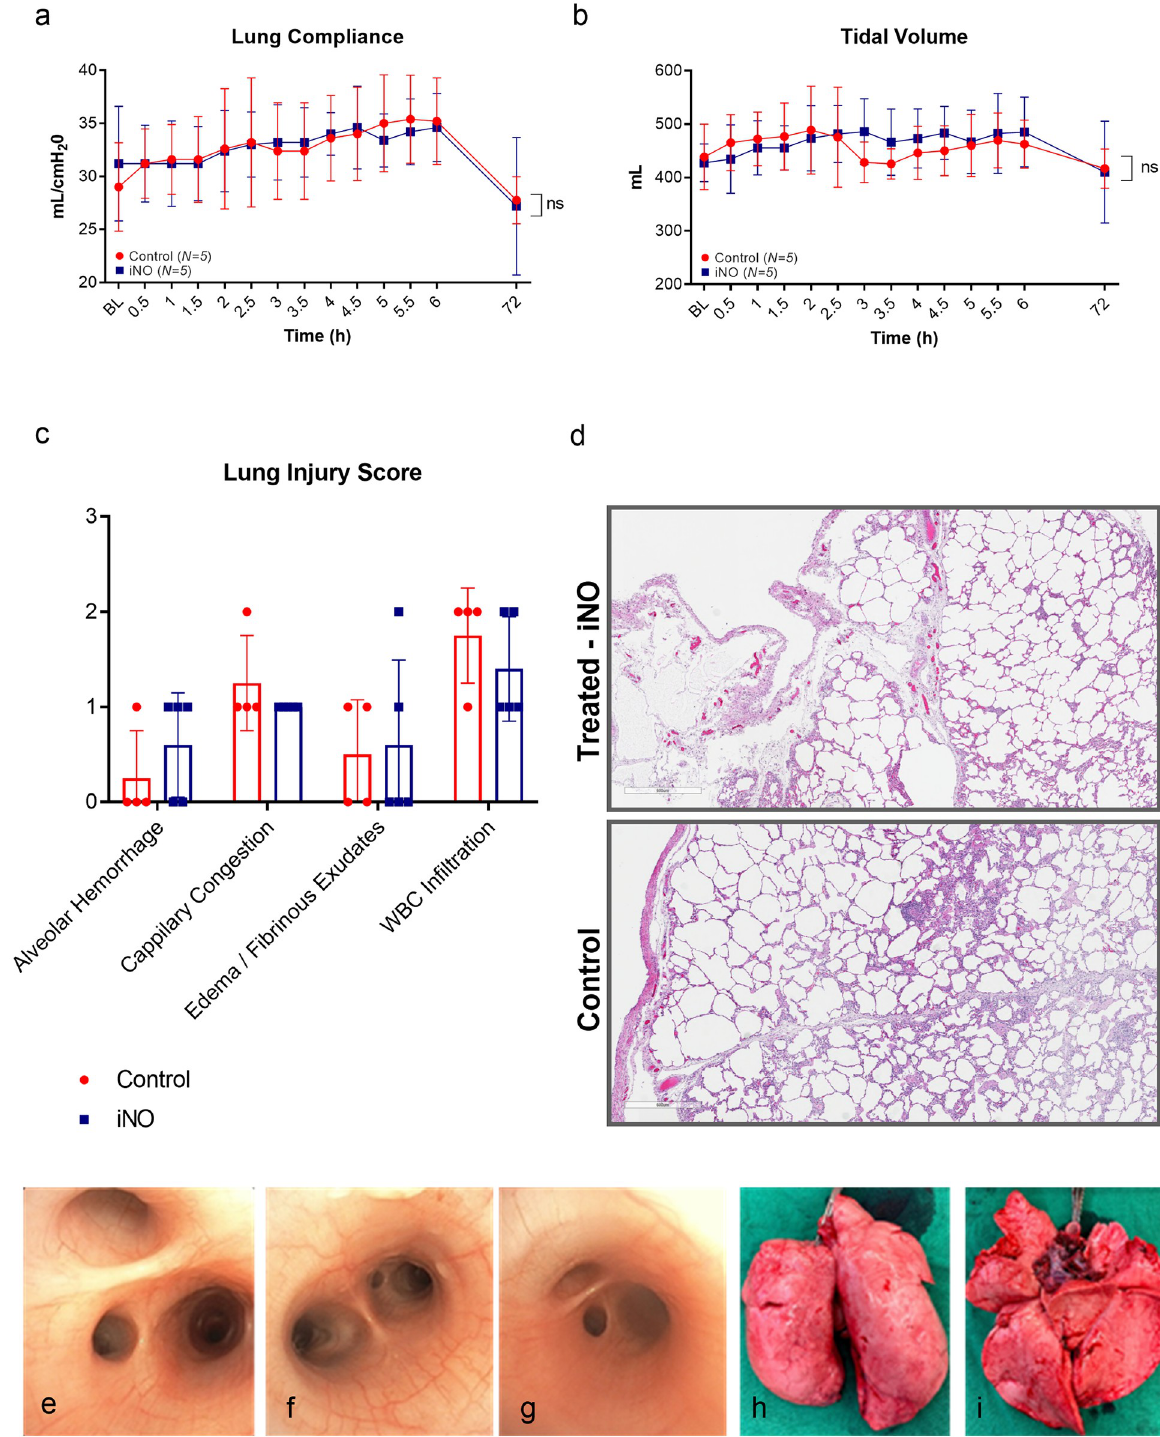
Fig 6. Pulmonary function, inflammation analysis, and histologic examination of the control group (red box/line, n = 5) versus treatment iNO group lungs (blue box/line, n = 5). The following lung functional parameters were evaluated: (a) lung compliance, (b) tidal volume. There was no significant difference between control and iNO treated animals. Acute lung injury score (c) was similar between the two groups in each evaluated component: Alveolar hemorrhage, capillary congestion, edema and WBC infiltration. Representative images (5X) of H&E stained biopsies of one control (bottom image) and one iNO treated animal (upper image) taken at 72 hours are shown in (d). Additionally, representative